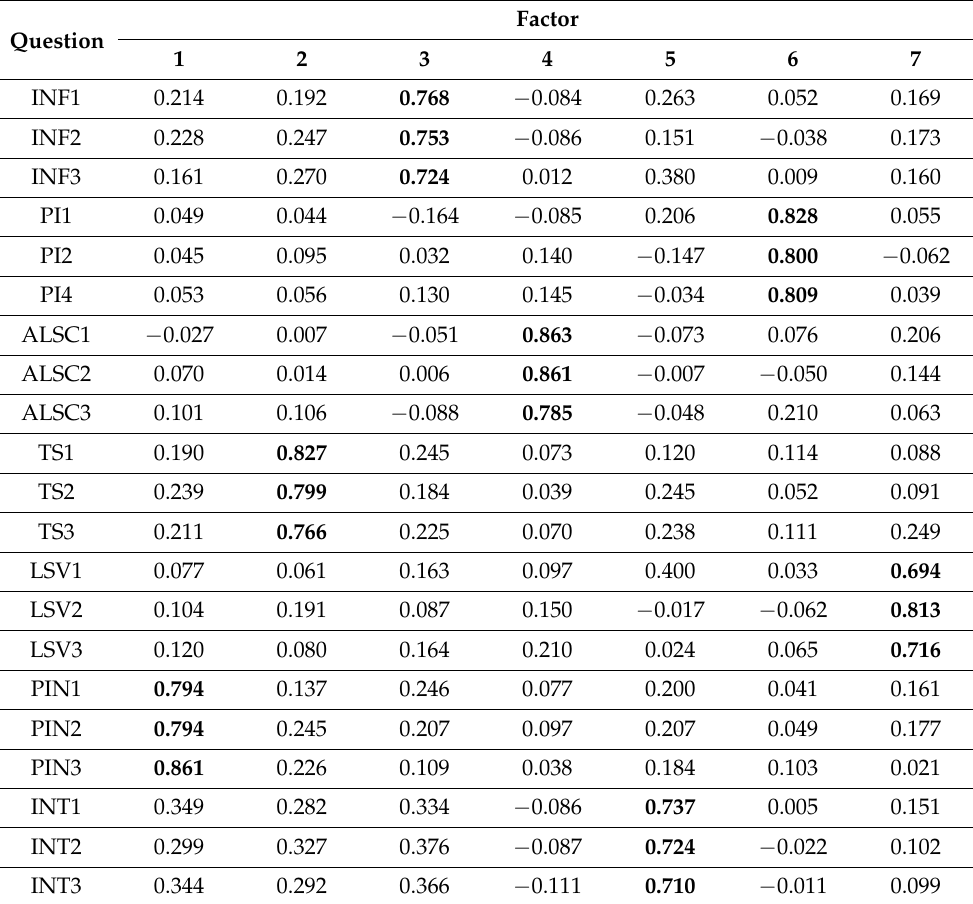
Table 5. Validity of